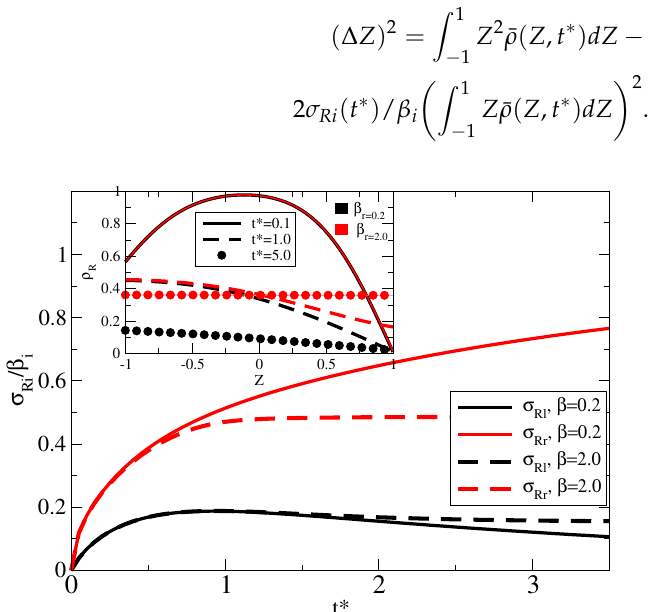
Figure 4. σ Ri / β i for two different values of β r . The left surface uses the same parameters as used in Figure 3, while the surface at Z = 1 uses τ κ r / τ r = 0.01 and τ ar / τ r = 0.01. From this figure, it becomes clear that increasing the β of a single surface changes the behavior of the opposite surface and that larger values of β mean higher coverage but a smaller overall number of adsorbed particles. The inset shows the bulk distribution for three different values of t ∗ and for β r = 0.2 and β r =